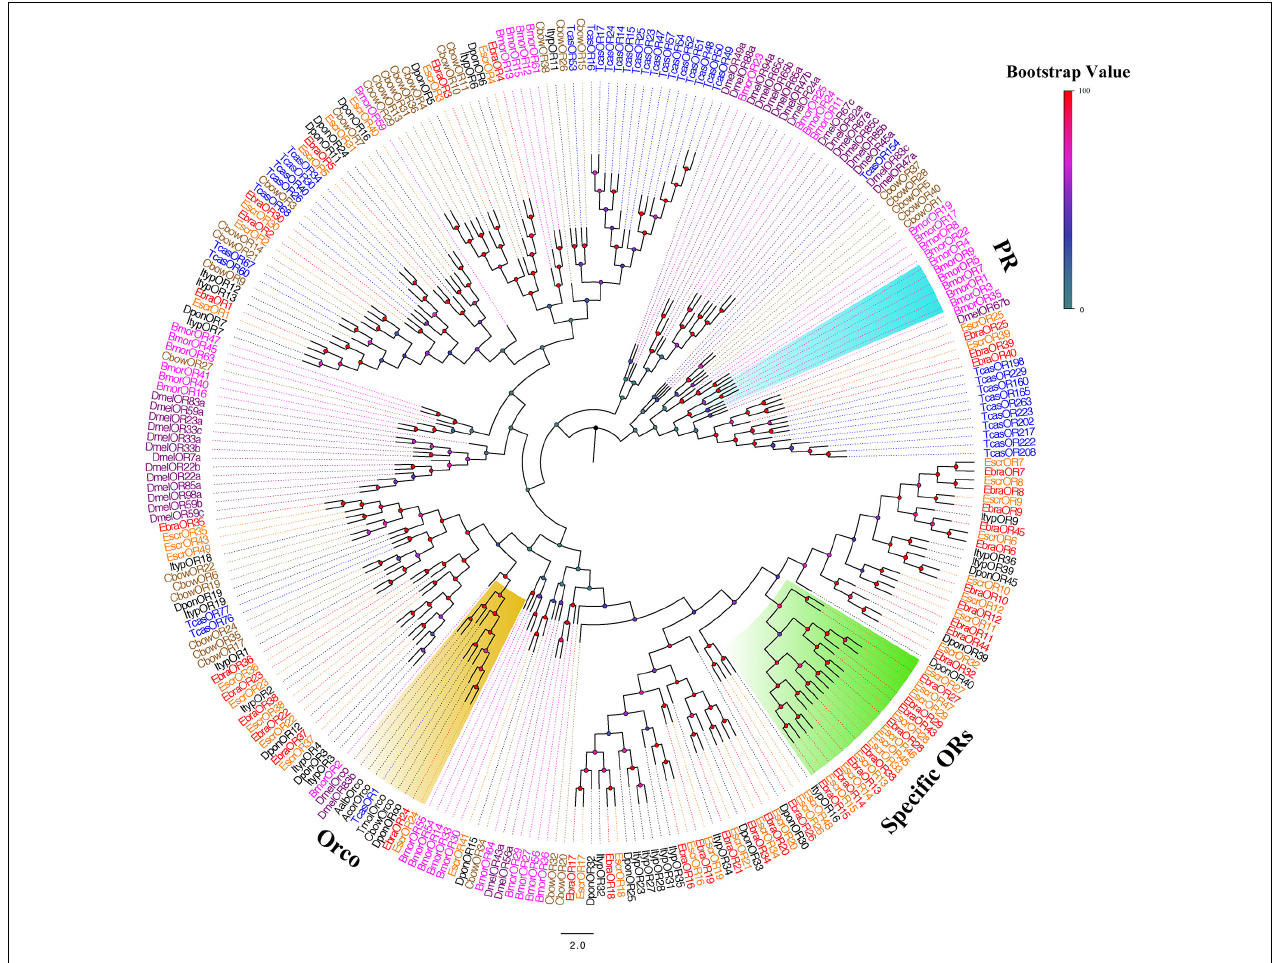
FIGURE 3 | Phylogenetic tree of putative odorant receptor (OR) genes. The E. scrobiculatus genes are shown in yellow and E. brandti genes are shown in red. The tree was constructed using MEGA6 with Neighbor-joining method. Amino acid sequences used for the tree are listed in Supplementary Table S10